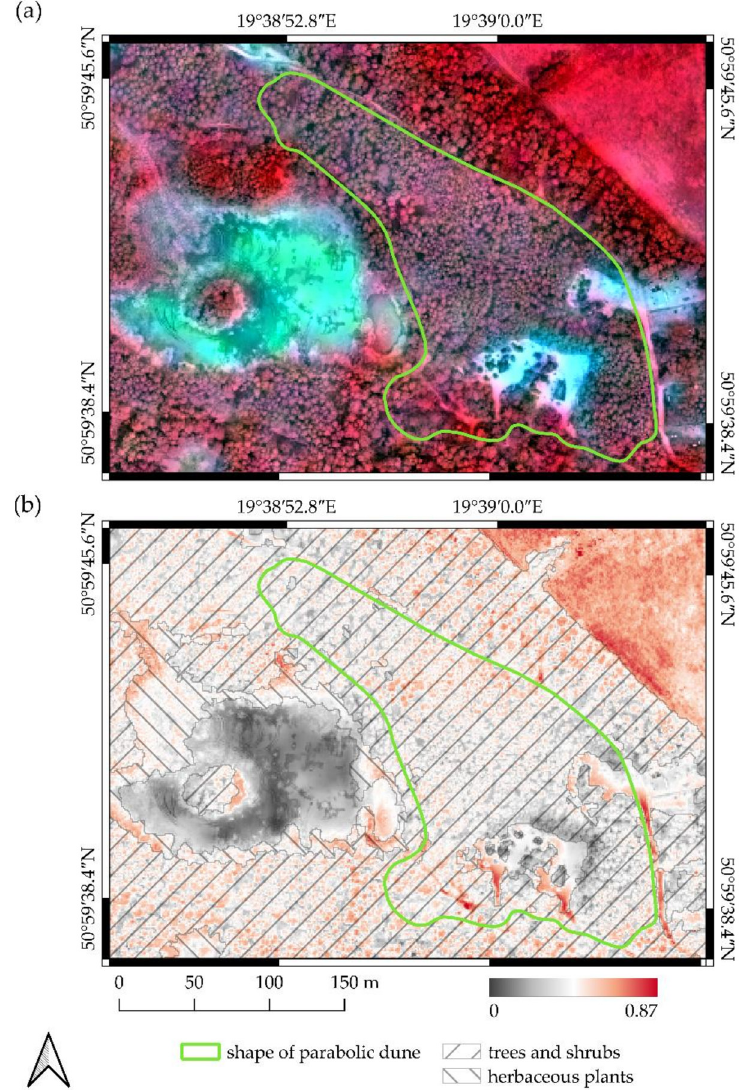
Figure 9. Assessing vegetation condition by ( a ) CIR imagery and ( b ) MCARI1 indices. In CIR, intensity tones of red colour represent areas of better vegetation condition, the blue colour shows a lack of